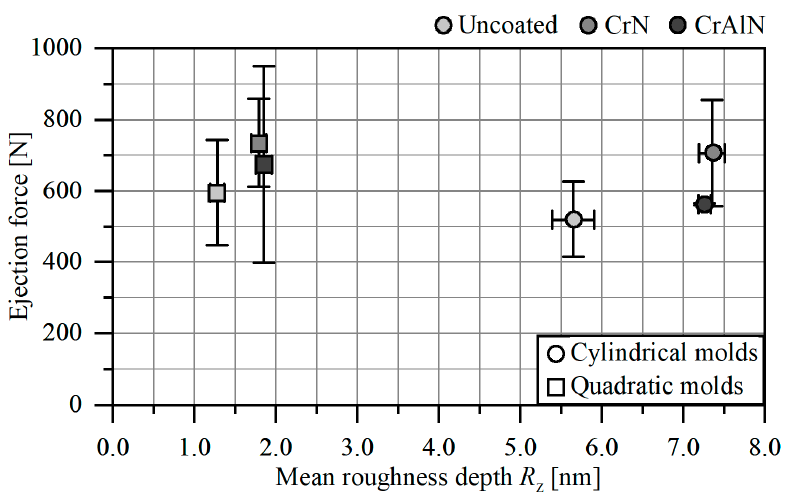
Figure 10. Ejection forces plotted against the average mean roughness depth R z .